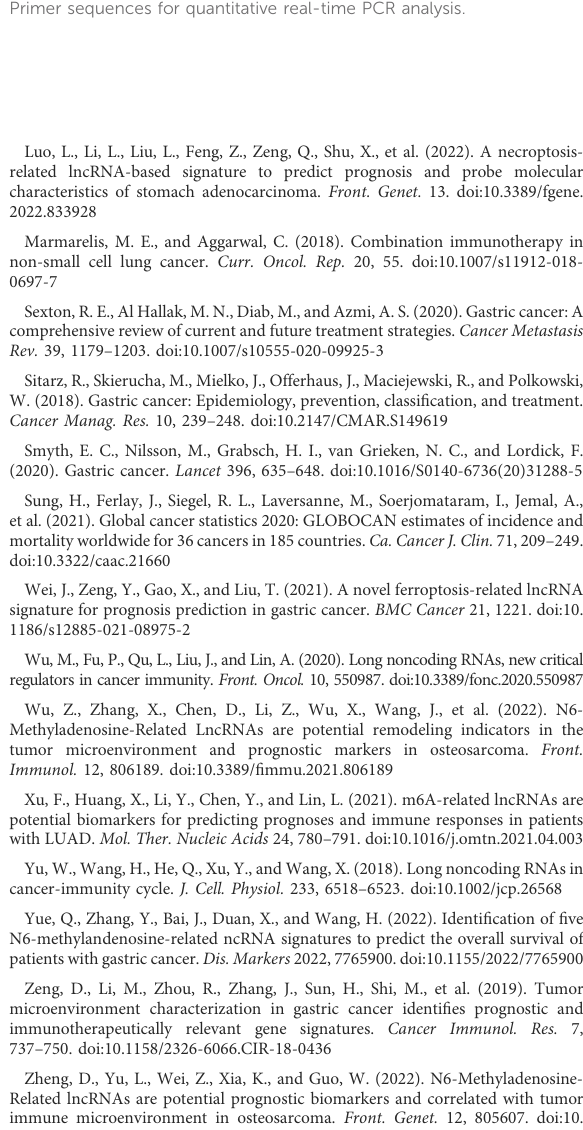
The details of KEGG enrichment analysis. SUPPLEMENTARY TABLE S9 The details of immune cell landscape. SUPPLEMENTARY TABLE S10 Primer sequences for quantitative real-time PCR